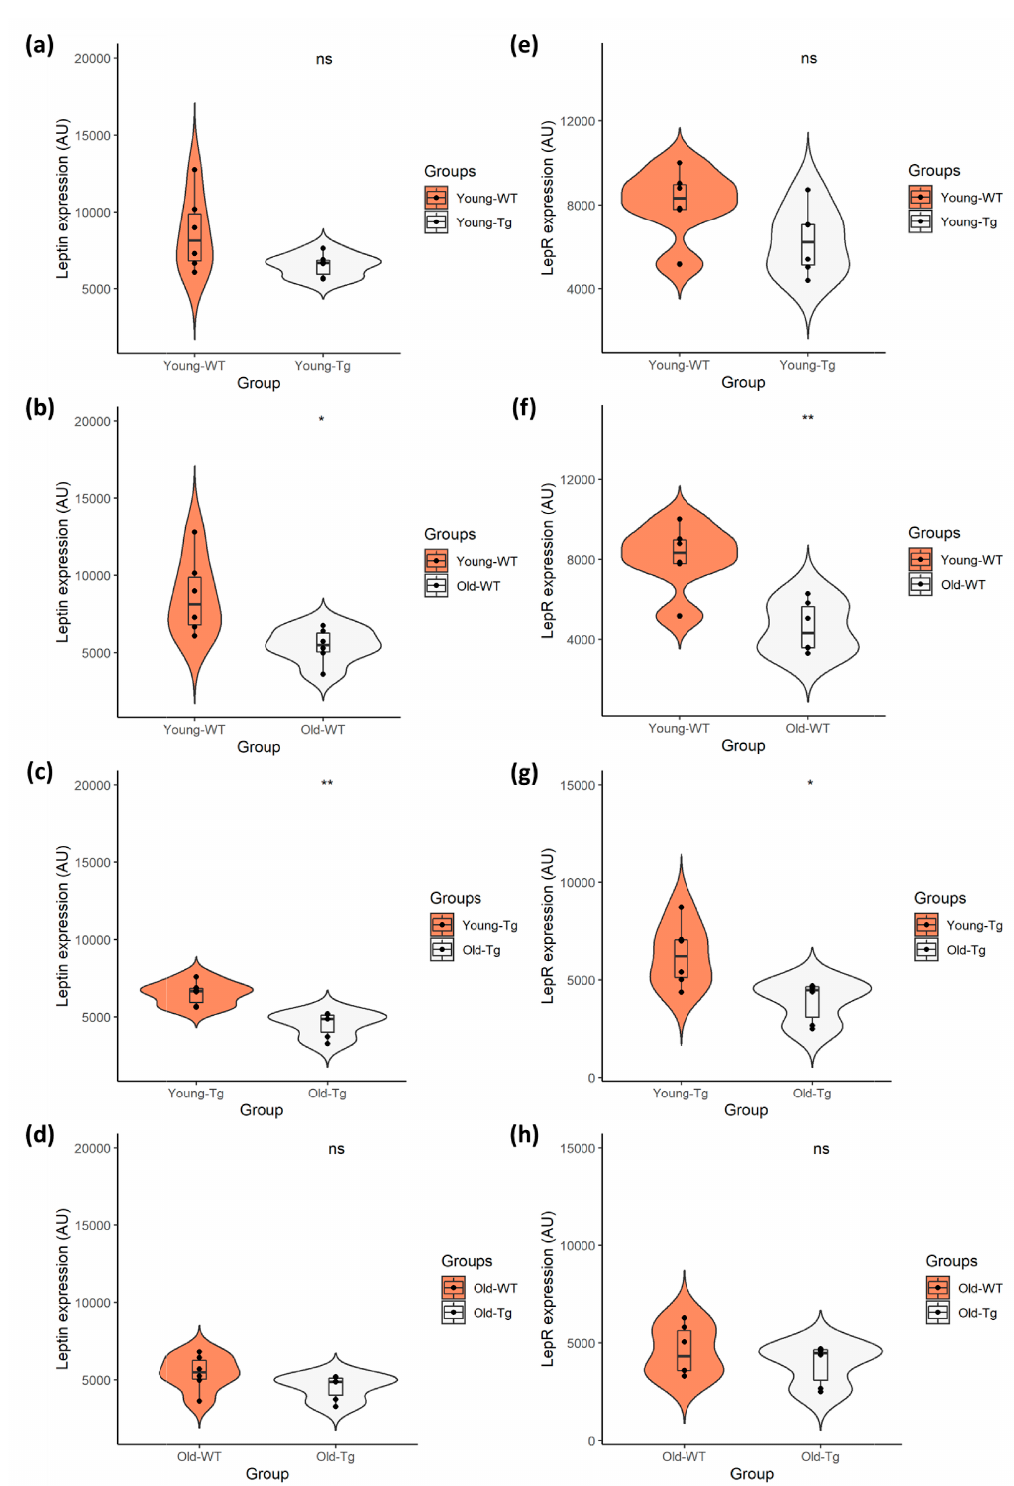
Figure 2. Quantitative analysis of neuronal leptin and LepR expression in young (10–12 week) and old (48–52 week) 5XFAD (Tg) mice and wild-type (WT) controls. Independent t-test analysis of ( a ) neuronal leptin and ( e ) LepR expression between the young-WT and young-Tg revealed no significant di ff erences. However, there was significant di ff erence in expression of ( b ) leptin and ( f ) LepR between the young-WT and old-WT groups. This was also observed with the ( c ) leptin and ( g ) LepR expression amongst young-Tg and old-Tg mice. However, there was no significant di ff erence in ( d ) leptin or ( h ) LepR expression between the old-WT and old-Tg mice. Data presented as violin plots using an independent t-test, with statistical significance indicated as * p < 0.05 and ** p < 0.01 between